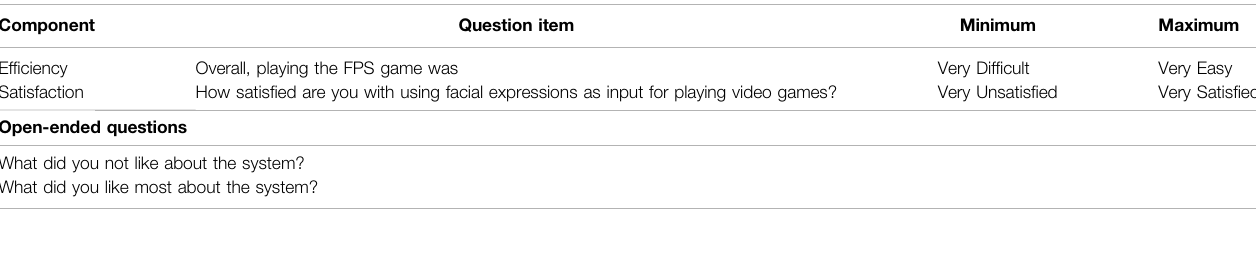
TABLE4| Thesecondpartofthepost-study questionnaire. Thequestionsherewereratedonaseven-pointLikertscale(1 (cid:1) stronglydisagree,7 (cid:1) stronglyagree).Foreach component, we also asked the participants to provide open-ended feedback on that component. Category